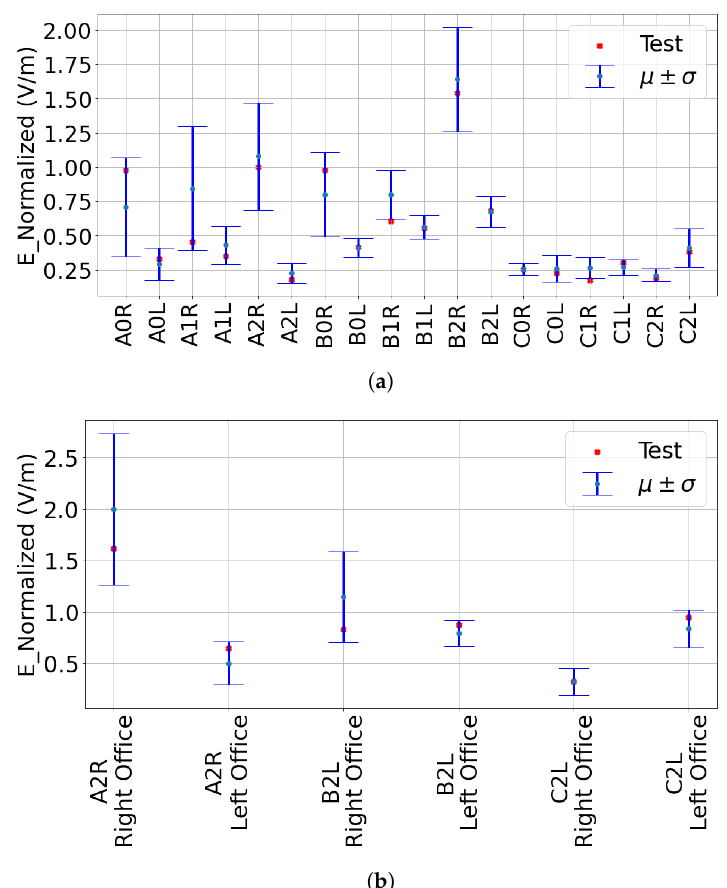
Figure 8. Validation of test point within one standard error from the mean in the wings of all buildings. (a) Corridors; (b)